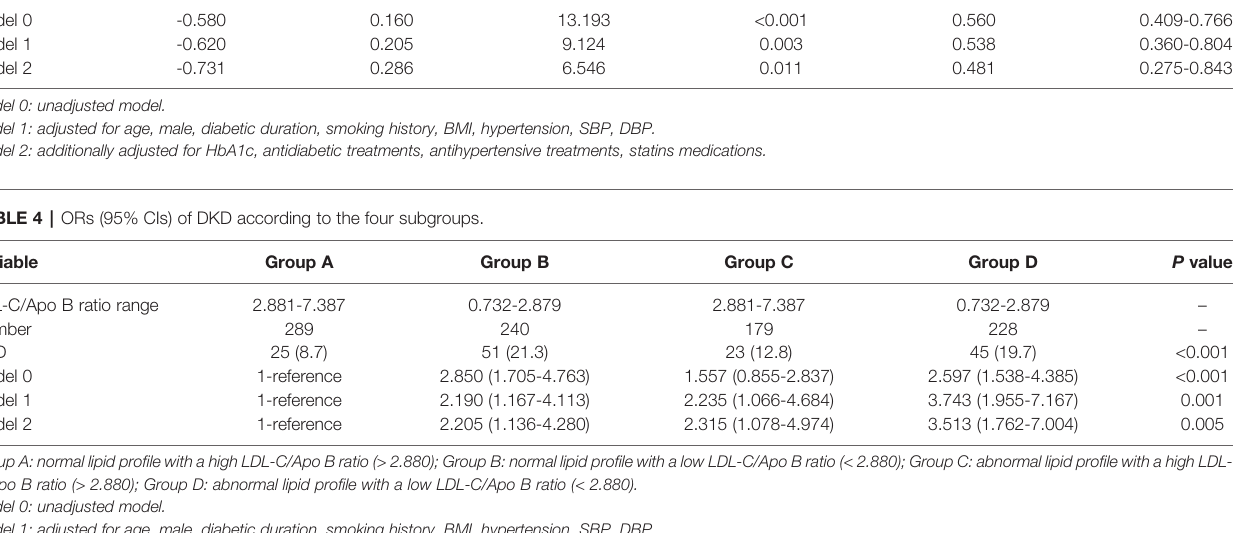
TABLE 3 | Multivariate logistic regression analysis to identify the association of LDL-C/Apo B ratio with DKD. Models